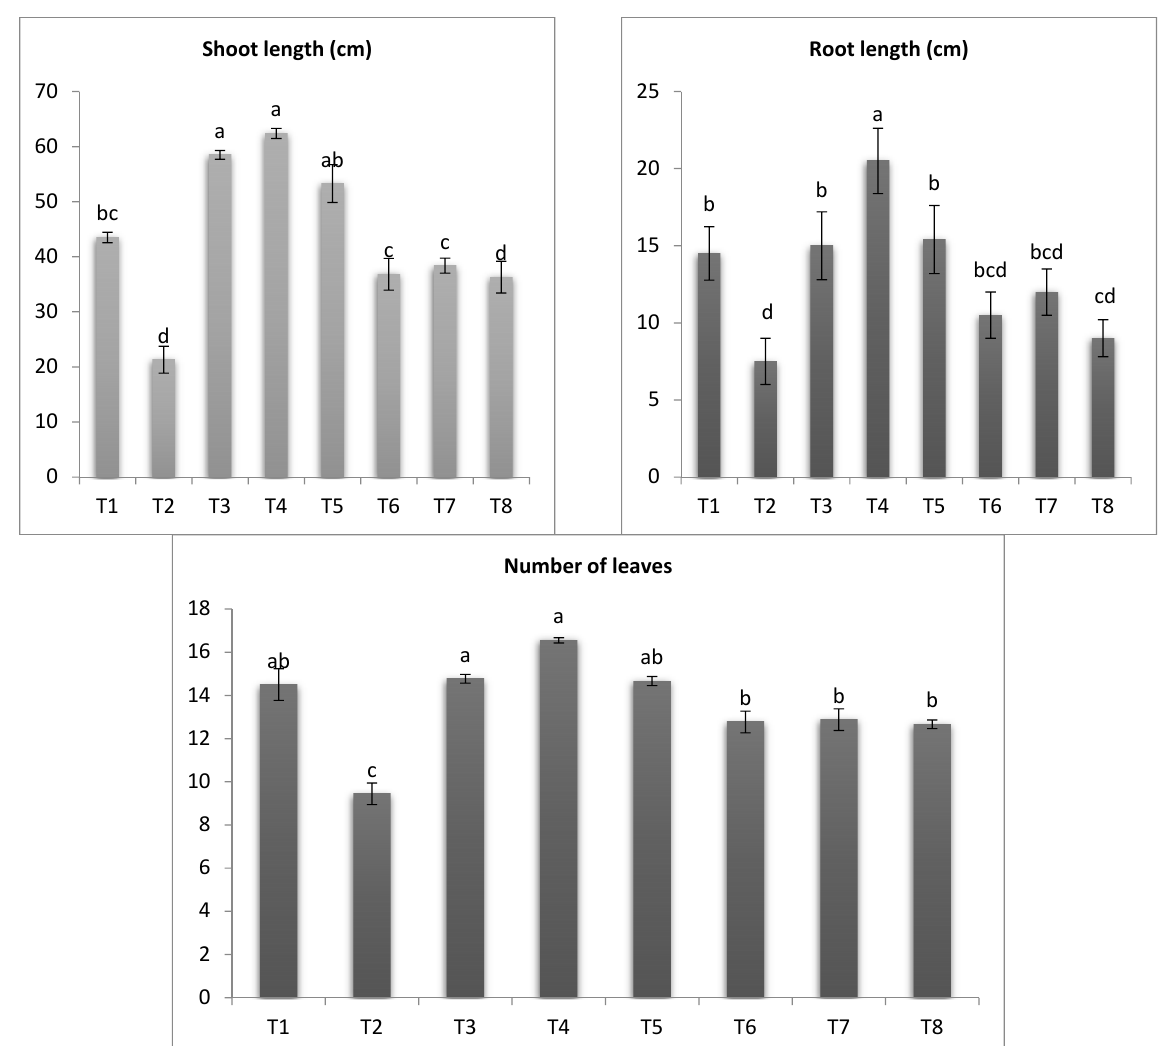
Figure 6. Effect of SiO 2 -NPs and sodium silicate on morphological characters of S. melongena. (Data represent mean ± SD, n = 3). (a–d revealed to significance letters).